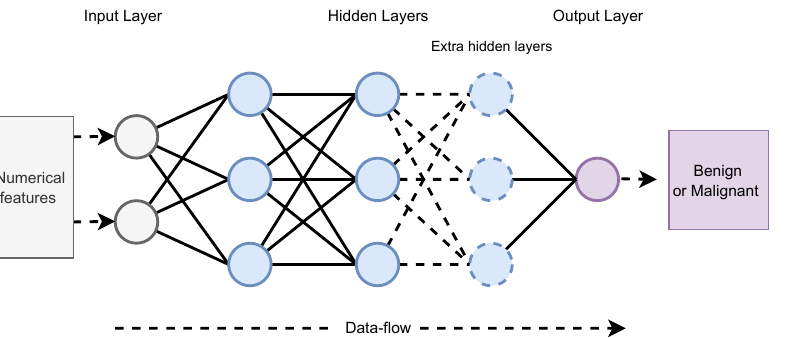
Figure 3. A sample illustration of ANN with multiple hidden layers for breast cancer diagnosis.